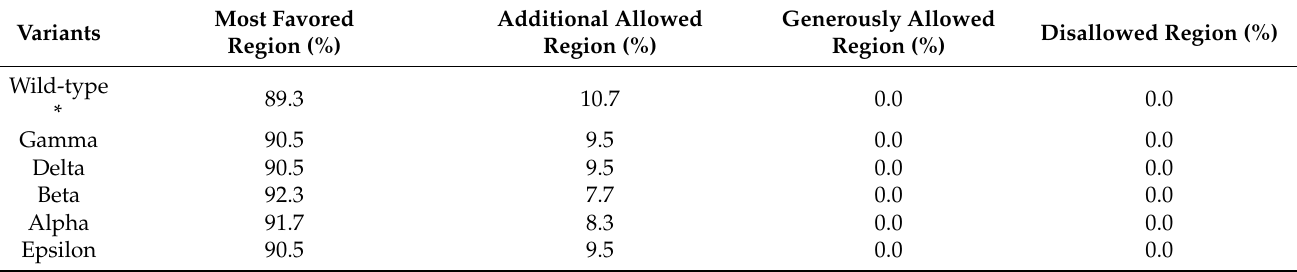
Figure 2. The Ramachandran plot analysis of the predicted models for the RBD variants: ( A ) WT, ( B ) Gamma; ( C ) Delta; ( D ) Beta; ( E ) Alpha; ( F ) Epsilon. Table 1. Ramachandran statistics for the predicted